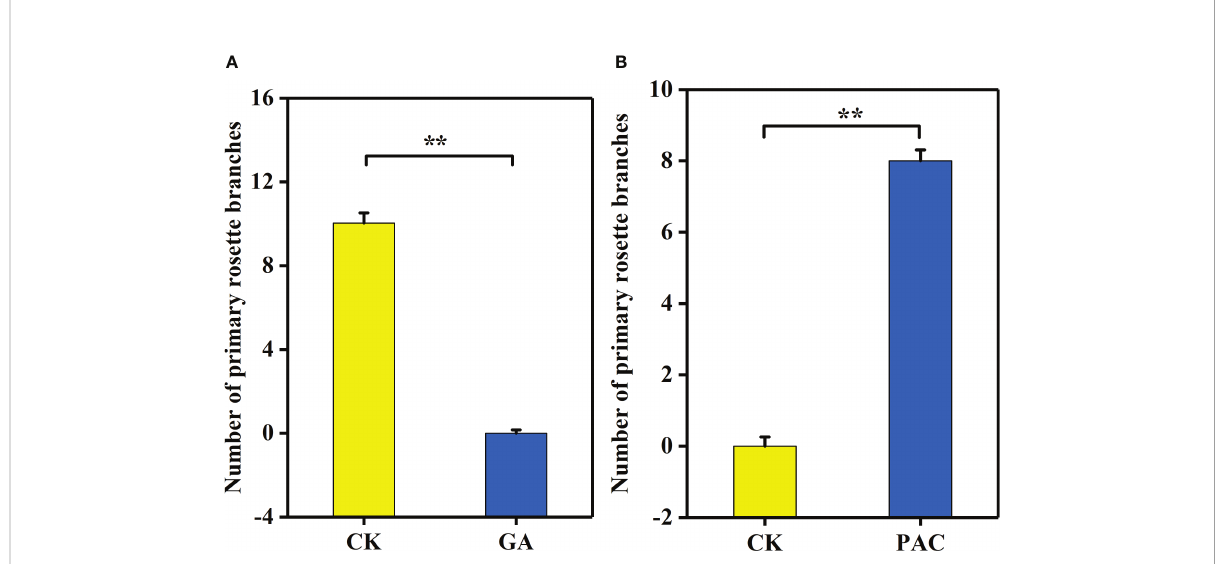
FIGURE 7 The number of primary rosette branches of CX020 and CX010 treated with exogenous GA 3 and PAC. (A) The CK and exogenous GA 3 treatment of CX020. (B) The CK and exogenous PAC treatment of CX010. The data shown are the means of three replicates (± SD). ** indicate signi fi cant differences in expression levels at P < 0.01 (Student ’ s